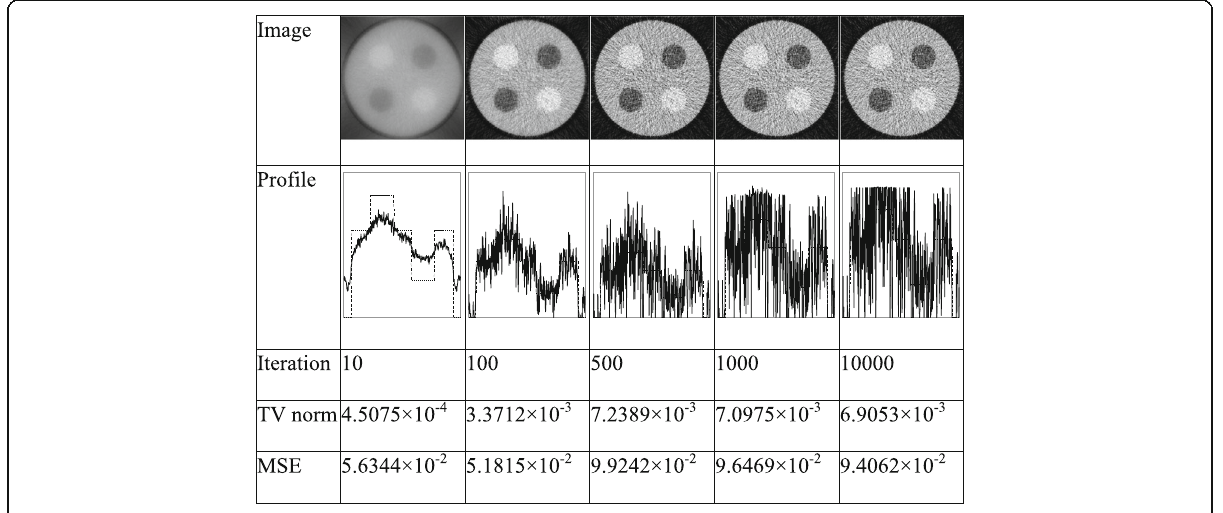
Fig. 10 Reconstructions with transmission data using the POCS algorithm in ref. [12] when I 0 =